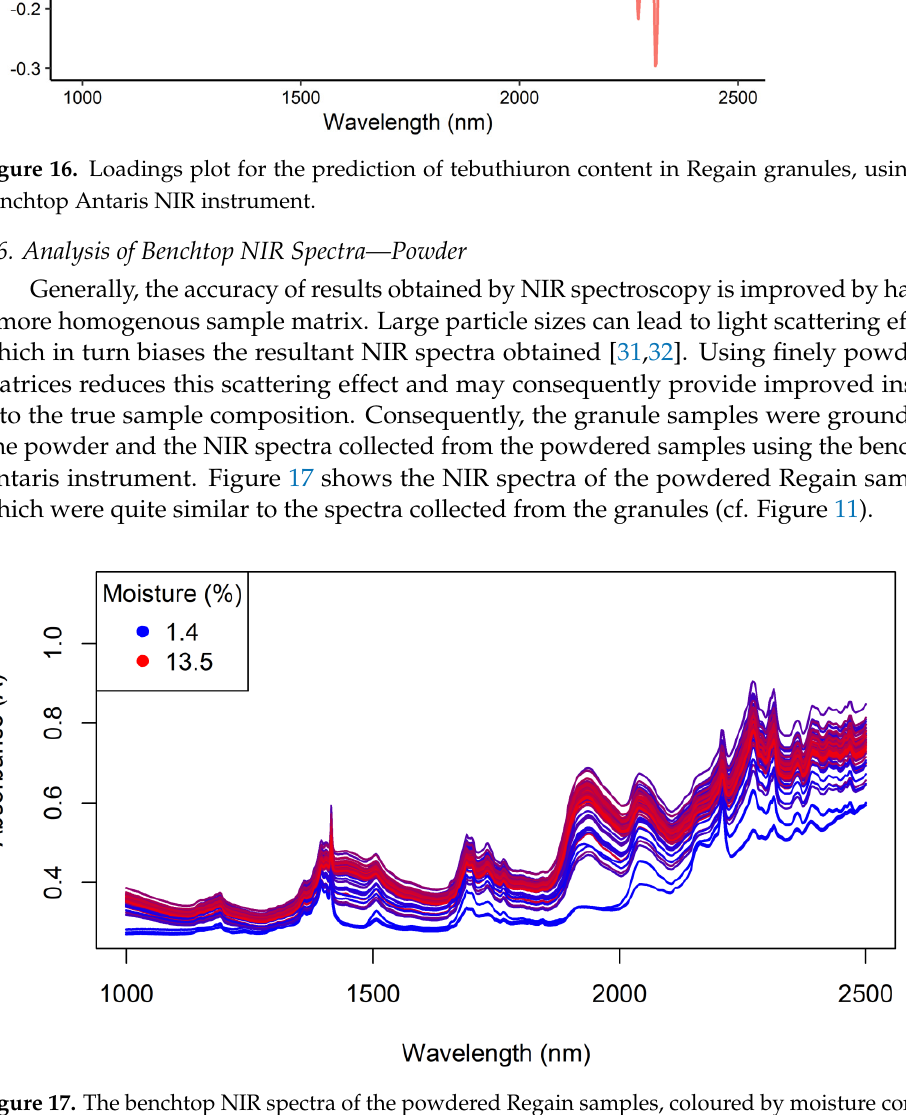
Table 8. Optimum pre-processing methods for the prediction of moisture and tebuthiuron content in powdered Regain samples using the benchtop Antaris NIR instrument. The best-performing model for each analyte is highlighted in bold.